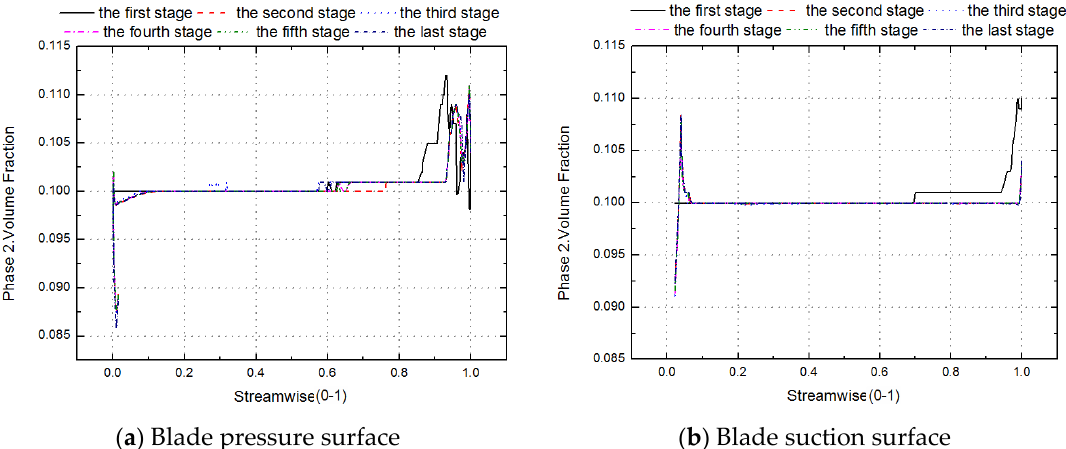
Figure 13. The distribution law of the GVF from the inlet to the outlet at the height of 0.5 times the blade height.